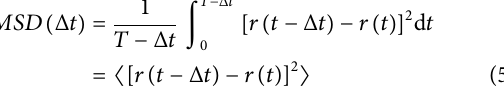
Frontiers in Chemistry |